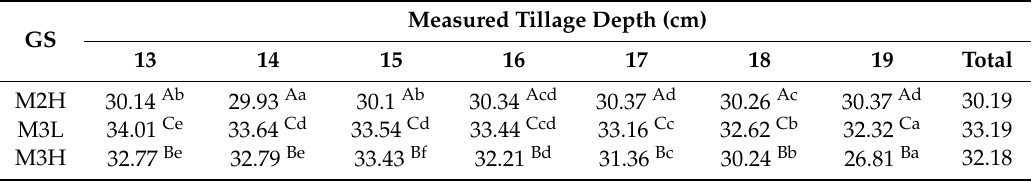
Figure 9. Overall front axle load according to the tillage depth and gear selections. Table 12. Mean front axle rotational speed (rpm) according to the tillage depth and gear selection